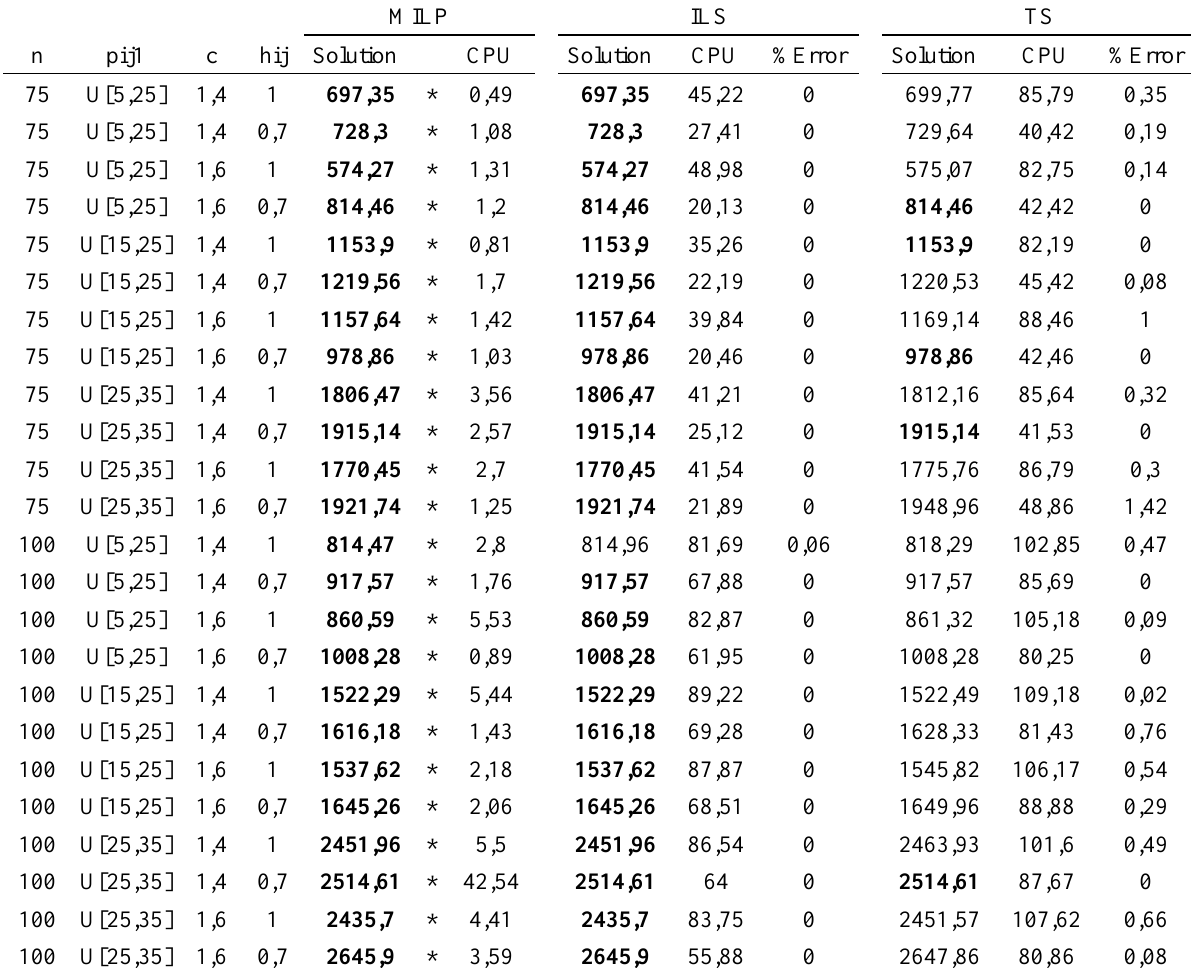
Table A1. Five agent and 75 or 100 jobs (* denotes optimal